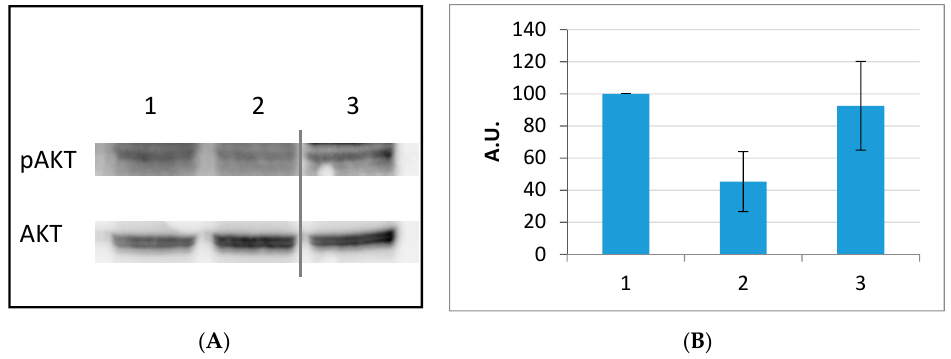
Figure 8. Western Blotting of pAKT. Analysis of the AKT phosphorylation state after peptide treatment was carried out on HepG2. Cells were treated with the RGDechi15D peptide for 1 h. ( A ) Total cellular extracts (50 µ g) were resolved by SDS PAGE and analyzed by Western blotting with anti-pAKT (Ser473) and anti-AKT antibodies. The Western blotting is representative of three independent experiments. ( B ) Bar graph illustrates the percentage of band quantification respect to the control. 1 = Control, 2 = RGDechi15D, 3 = Scrambled peptide. The results are expressed as mean ± SE of percentage of pAKT normalized to the density of